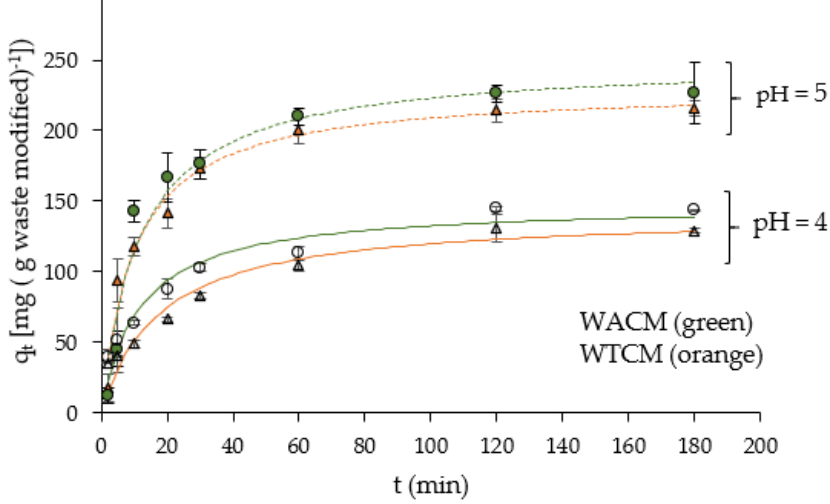
Figure 9. q t vs. time t. C 0 = 48.4 (continuous lines) and 130.8 mg L − 1 (dotted lines); dose = 2 g L − 1 , T =